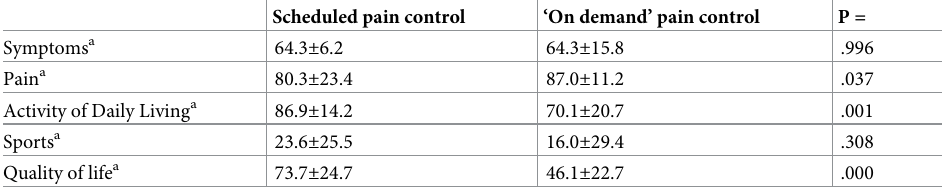
Table 5. KOOS subscales 3 months after surgery.